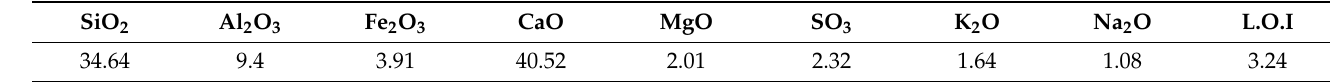
Table 1. Chemical compositions of cement (%).